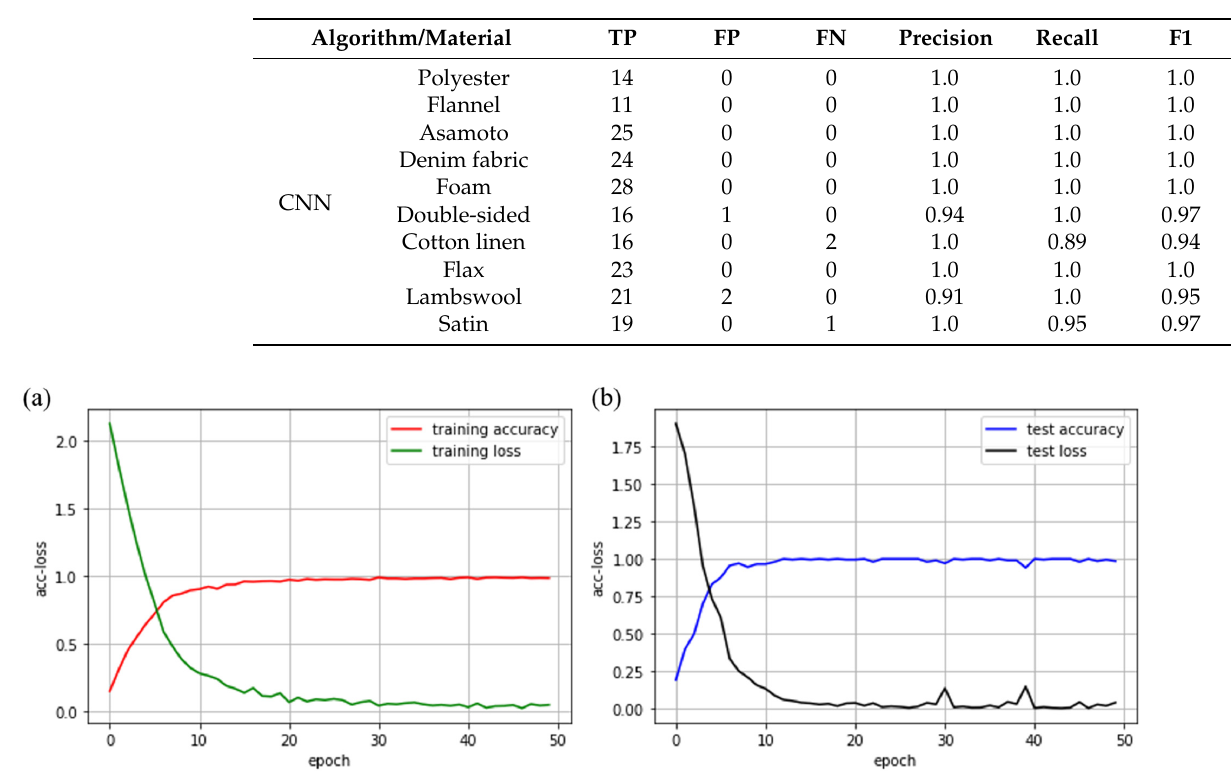
Table 3. Detection results of convolutional neural network.